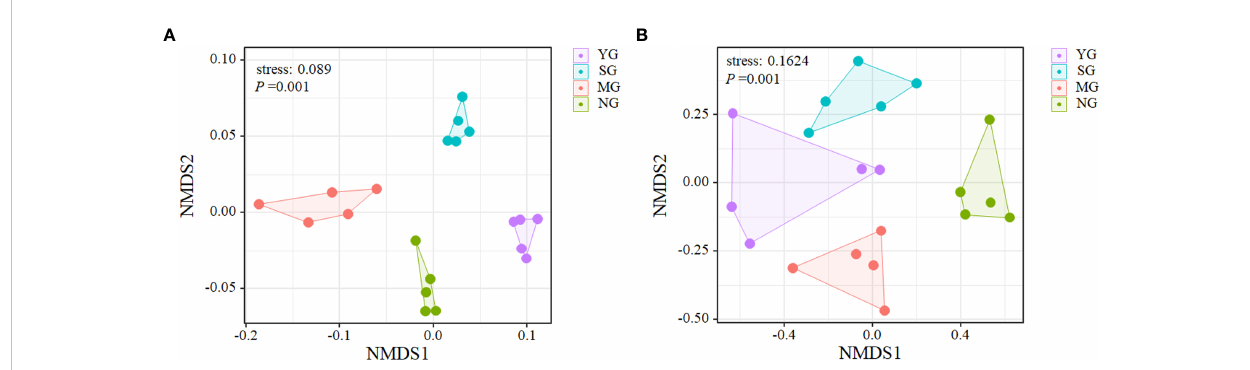
FIGURE 1 Non-metric multidimensional scaling (NMDS) ordination of all sampling units indicating the relative differences in bacterial (A) and fungal (B) community compositions. YG, Yak grazing; SG, Tibetan Sheep grazing; MG, Yak and Tibetan sheep mixed grazing; NG, No